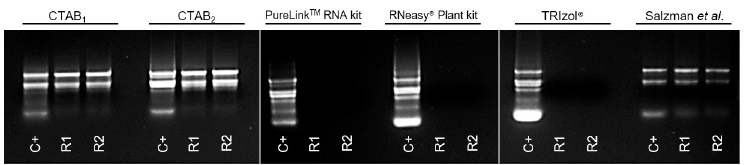
Fig 1. Qualitative analysis of RNA by agarose gel electrophoresis. Denaturing agarose gel (1%) electrophoresis of total extracted RNA (2 μ L) stained with GelRed (Biotium, Fremont-CA–USA). For the positive control (C+), total RNA was extracted from soybean ( Glycine max ) leaves, and extractions using P . guajava leaves were performed in duplicate (R1 and R2).